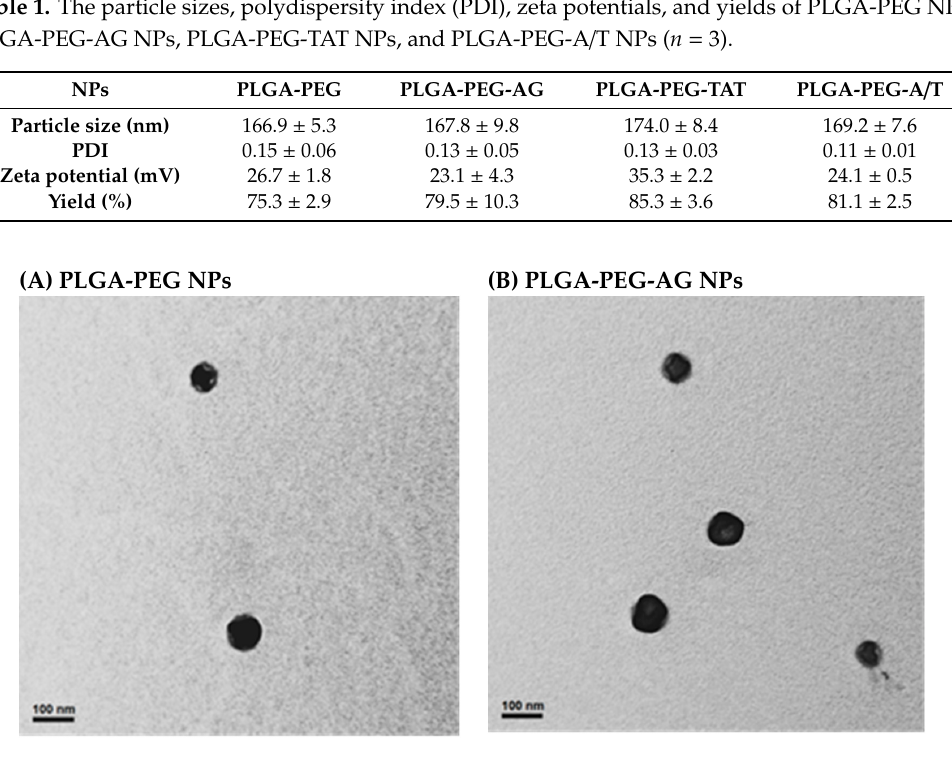
Table 1. The particle sizes, polydispersity index (PDI), zeta potentials, and yields of PLGA-PEG NPs,